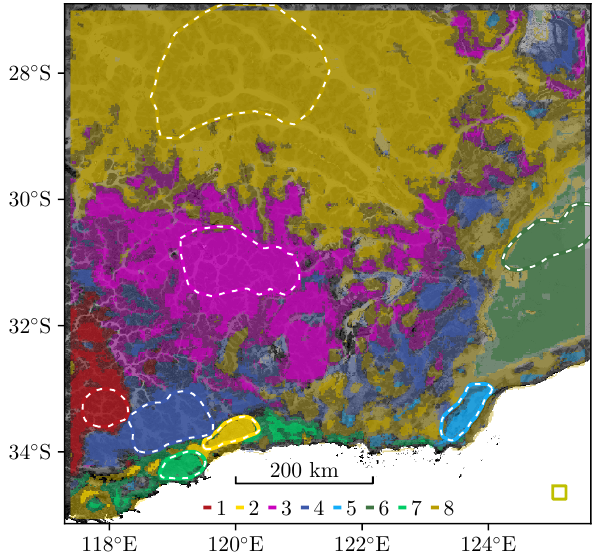
Figure 8. Map with transition belts, RF-100 at s = 21km. Clear, semiopaque, and mostly opaque areas denote <40%, 40–80%, and >80% probability, respectively, that a given tile belongs to the indicated